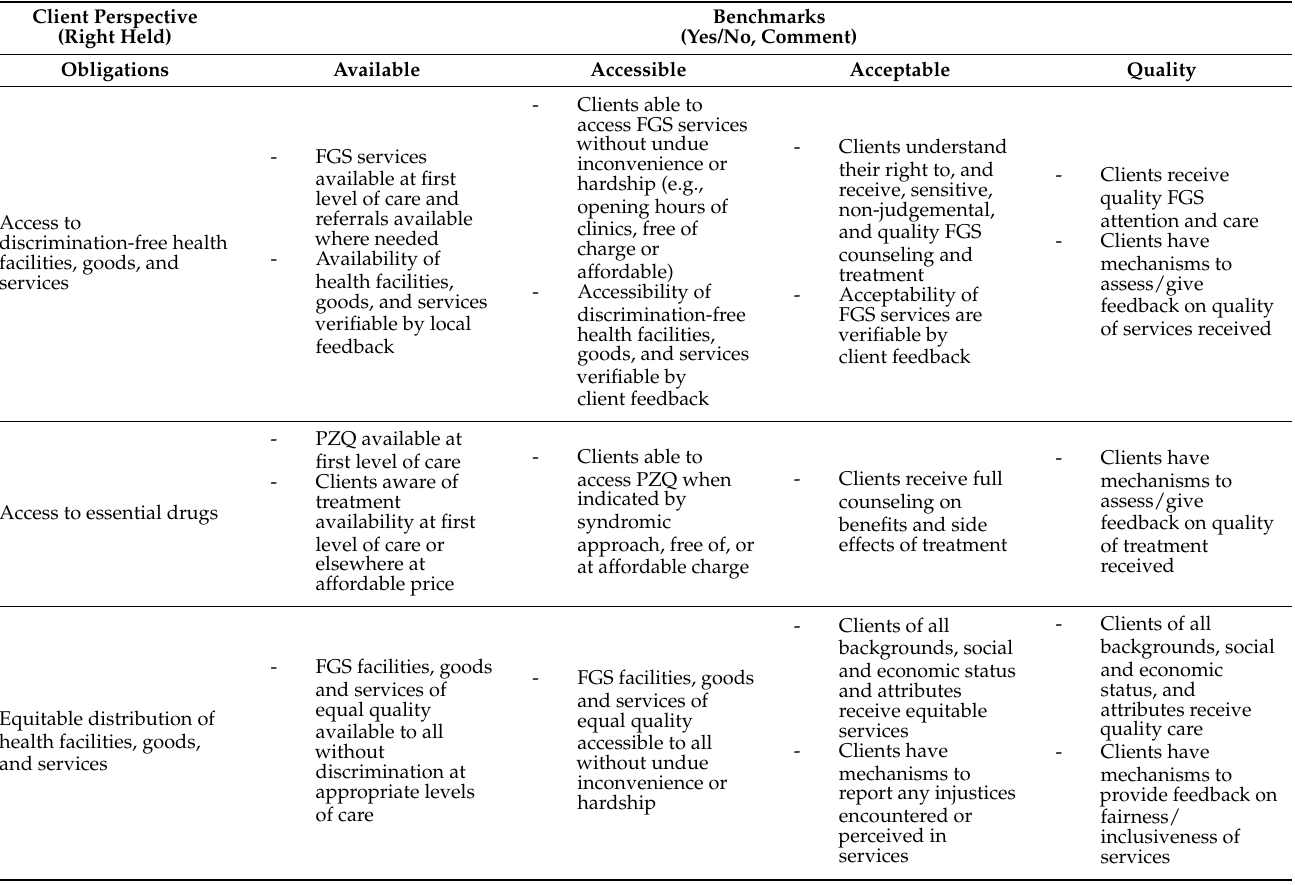
Table 2. Framework (Part 2) to assess clients’ realization of gender-related health care rights vis- à -vis female genital